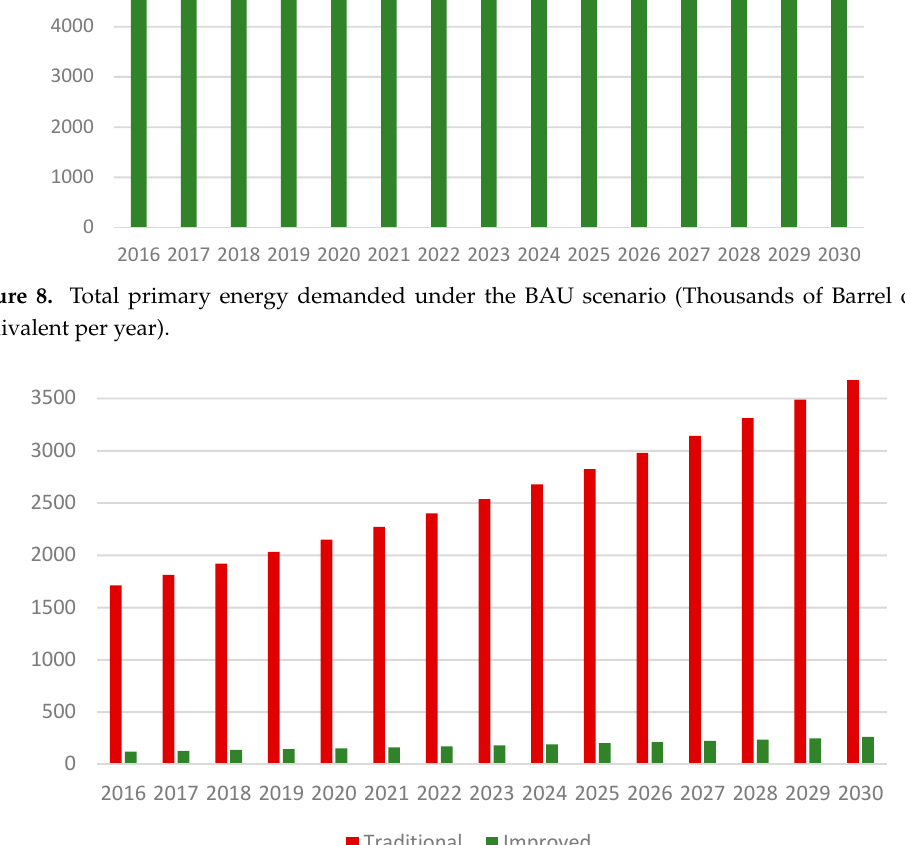
Figure 9. Firewood demand in urban households under the BAU scenario. (Thousands of Barrel of Oil Equivalent per year).